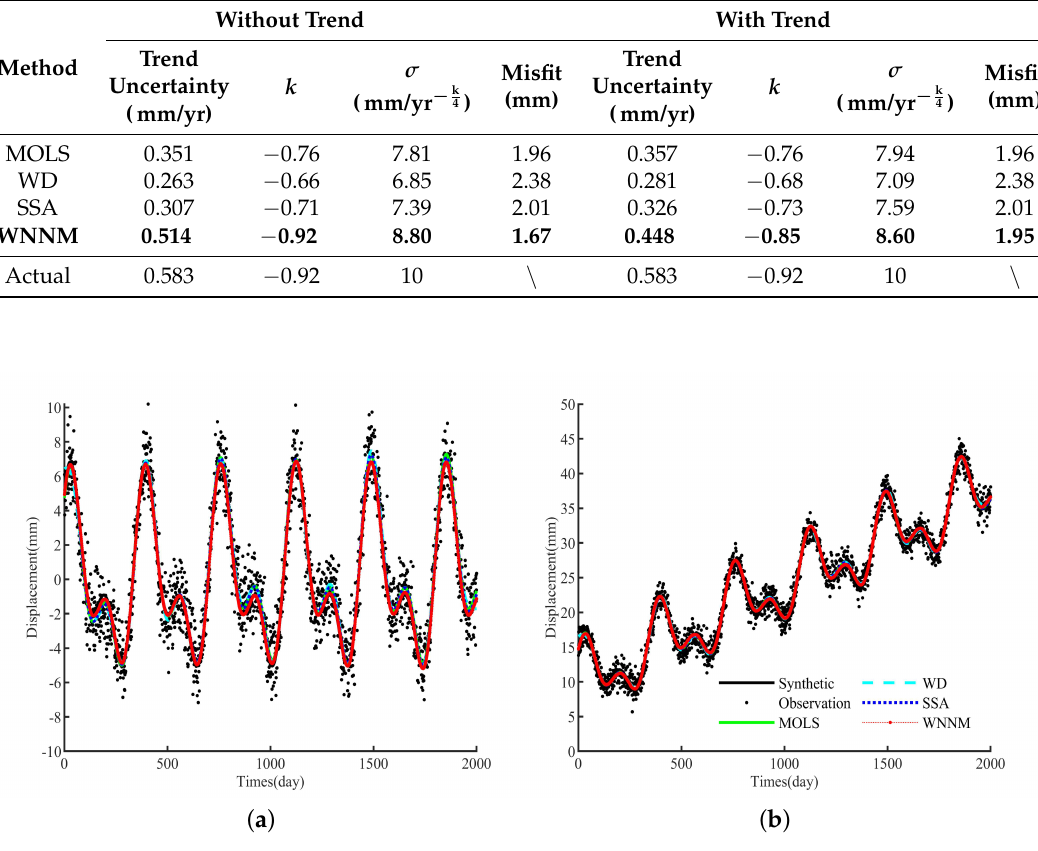
Figure 5. Comparison between extracted signal and original GNSS time series, where σ w = 1mm, σ f = 1mm/yr − k 4 . Black scatter shows GNSS observed time series, black solid line represents the simulated GNSS time series and green, cyan, blue and red lines represent signals extracted by applying MOLS, WD, SSA and WNNM, respectively. ( a ) Without trend and ( b ) with a linear trend.